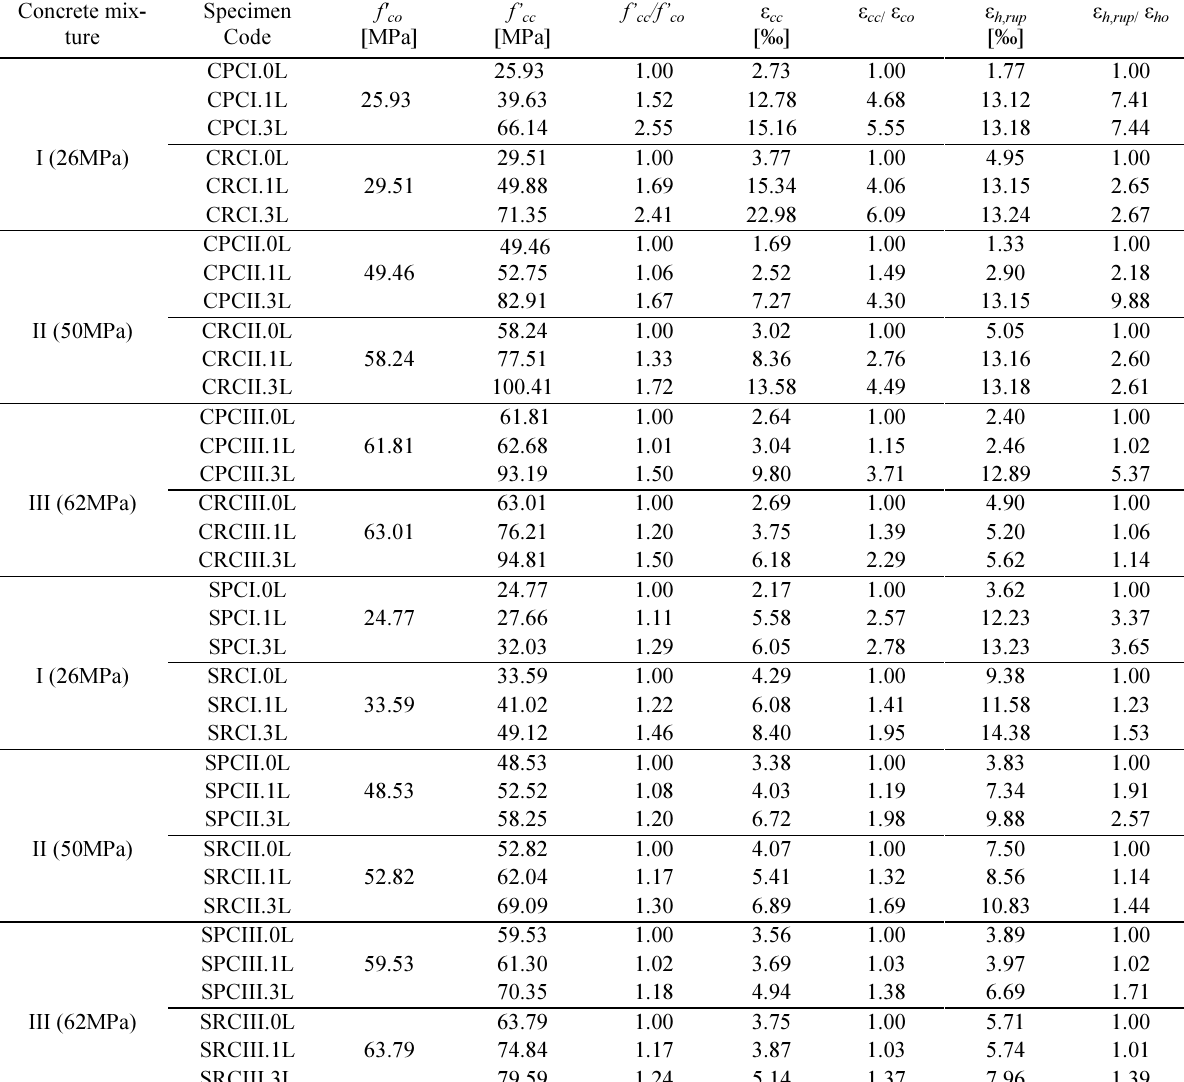
Table 3. Mean-values of experimental results of CFRP-wrapped specimens Concrete mix-